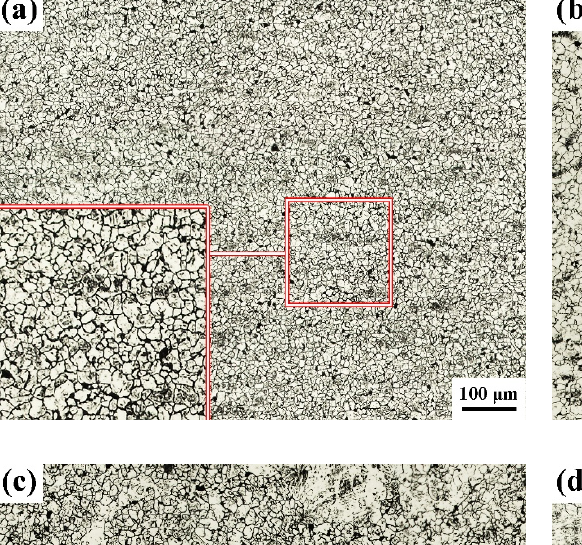
Figure 3. PAGSs after holding for 4 h at 977 °C of ( a ) S2, ( b ) S4, ( c ) S5, and ( d ) S6.